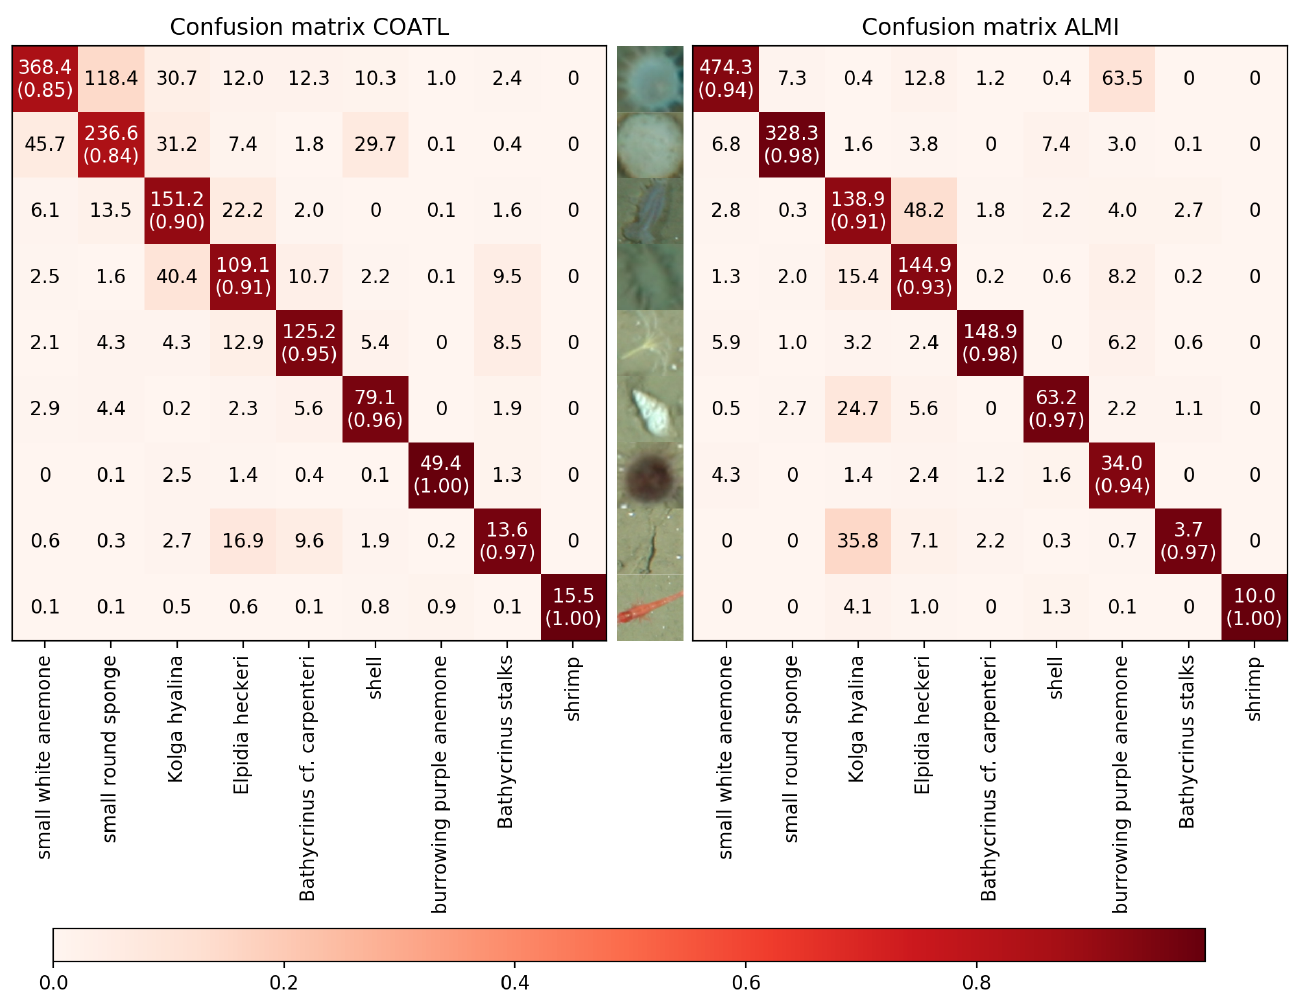
Figure 6. Left: confusion matrix of COATL after 150 iterations. Right: confusion matrix of ALMI after 150 iterations. The ι -th row of a matrix shows in the κ -th column how often an instance of class ι has been labeled as κ . The number in brackets in a cell ( ι , ι ) represent the class-wise accuracy obtained by the classifier for class ι according to Equation (14). The color of a cell ( ι , ι ) encodes the class-wise accuracy of class ι according to the color bar on the bottom. The colors in the other cells ( ι , κ ) represent the fraction of the number in ( ι , κ ) in the sum of all numbers in the ι -th row or κ -th